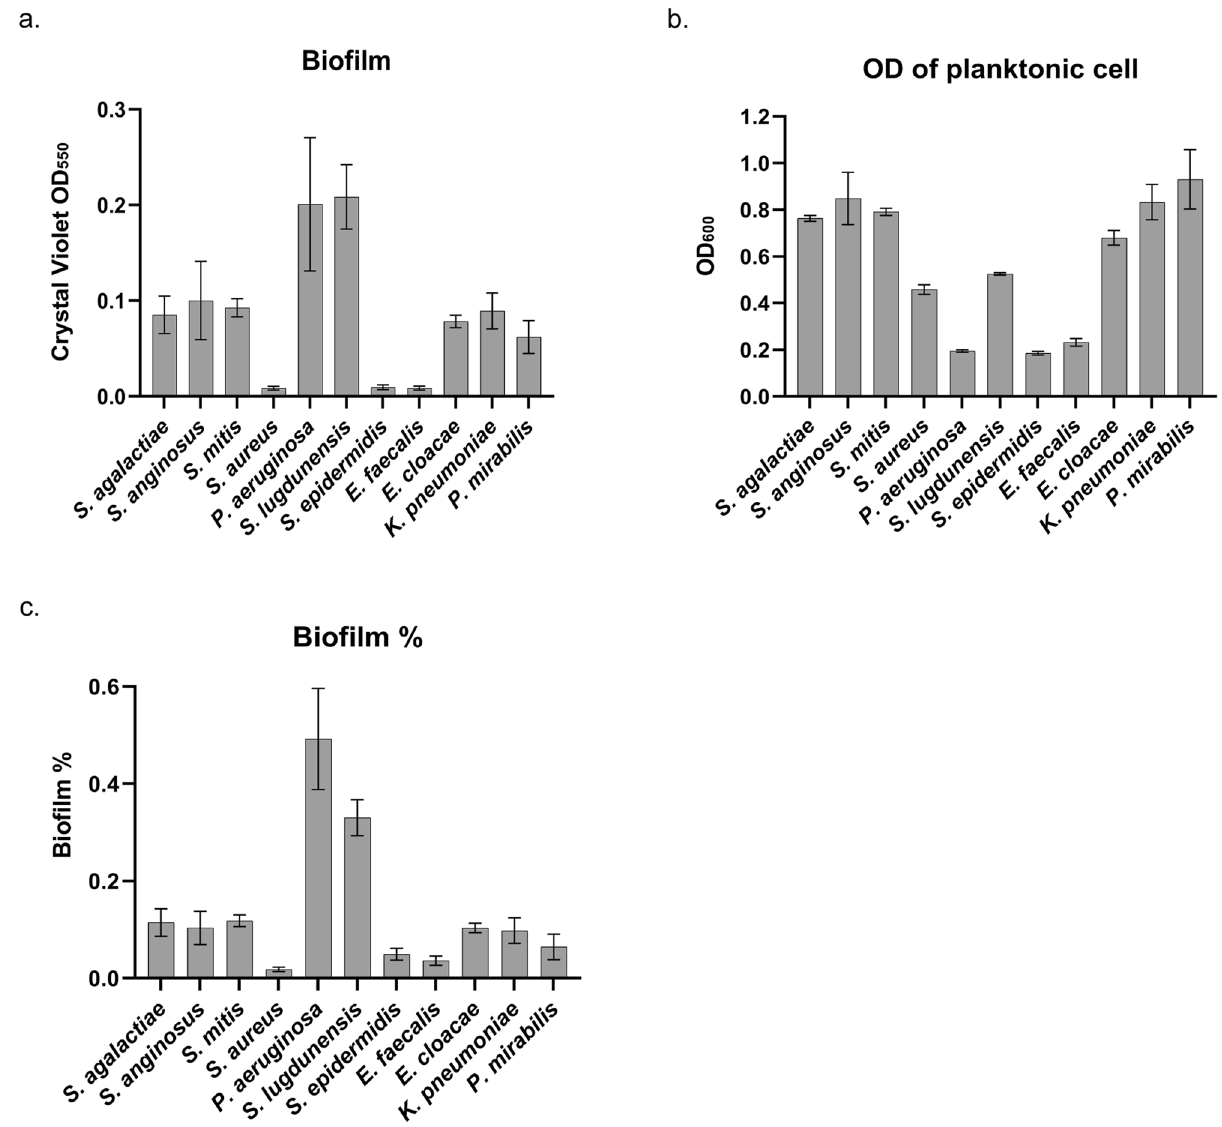
Figure 3. Biofilm formation on titanium (Ti). Each microorganism was cultured on a Ti plate for 72 h. Then the supernatants and Ti plates were collected separately. ( a ) The Ti plates were stained with CV, and their absorbance was quantified at 550 nm to detect biofilm formation on the surface. ( b ) The OD of non-adherent planktonic cell-containing supernatants was measured at 600 nm. ( c ) The OD values obtained from the CV assay for biofilm formation were divided by the sum of OD values from the CV assay for biofilm formation on the surface and from planktonic cell-containing supernatant to calculate the ratio of biofilm formation.